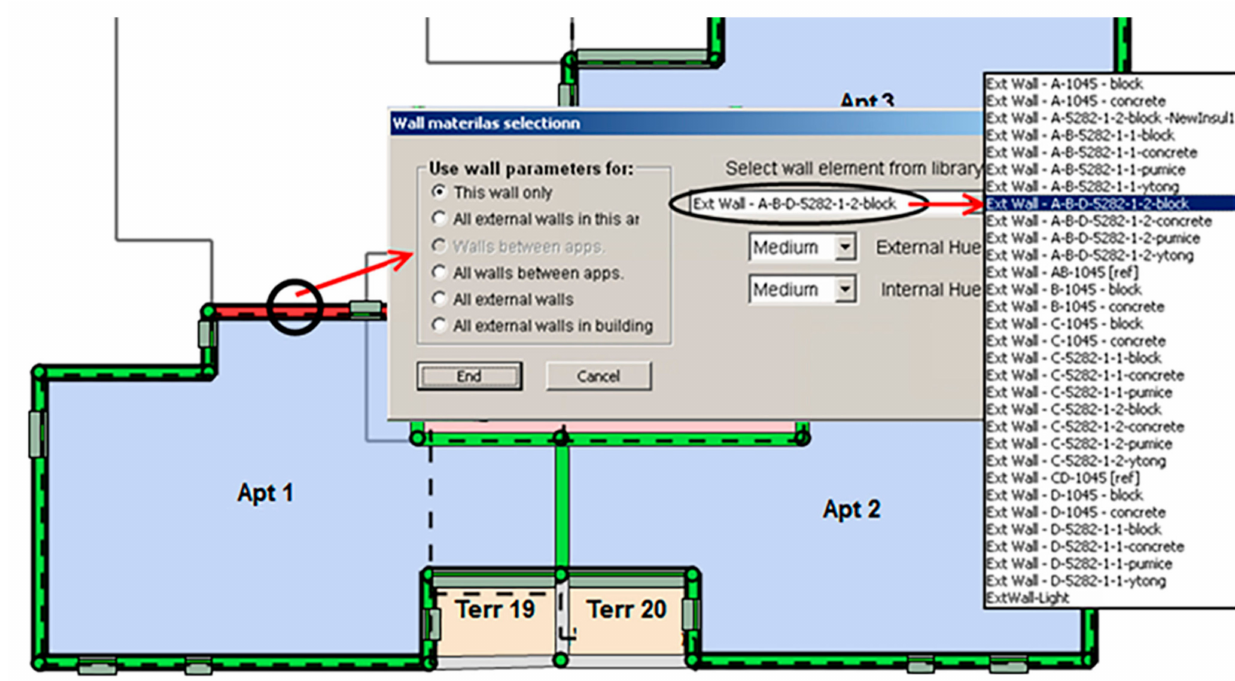
Figure 5. Opaque envelope: Assignment of composite elements.